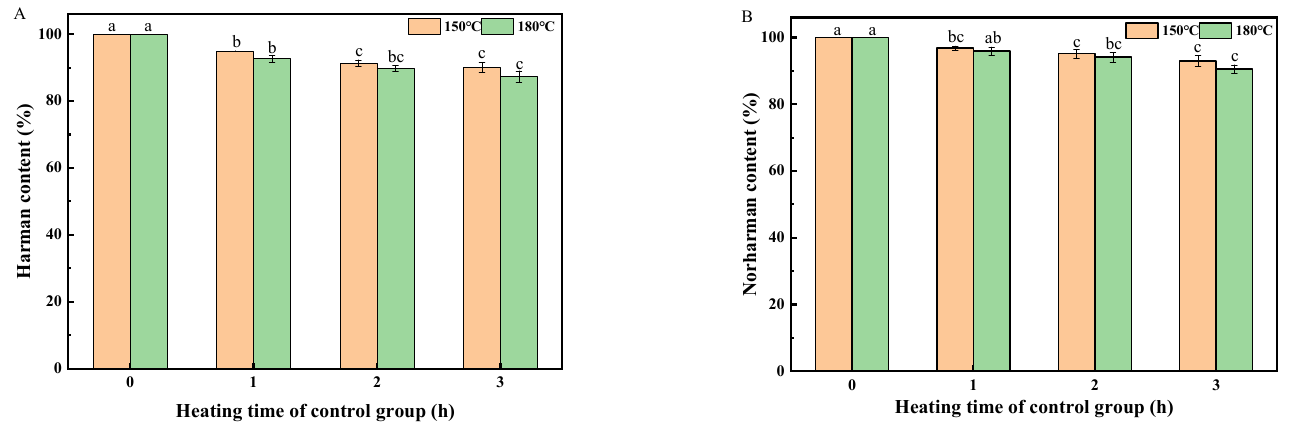
Figure 5. The content of harman in high-oleic-acid sunflower seed oil blend (HOSFO&SSO) under control conditions (heating without oxygen) ( A ), the content of norharman in HOSFO&SSO under control conditions (heating without oxygen) ( B ). Different superscript letters indicate a significant difference at p -value < 0.05.